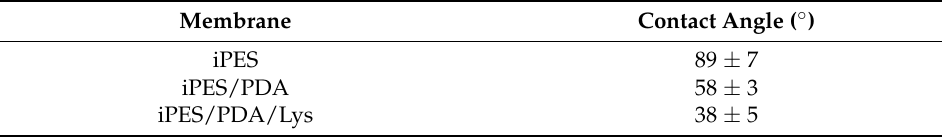
Table 1. The blood contact angle of the membranes.